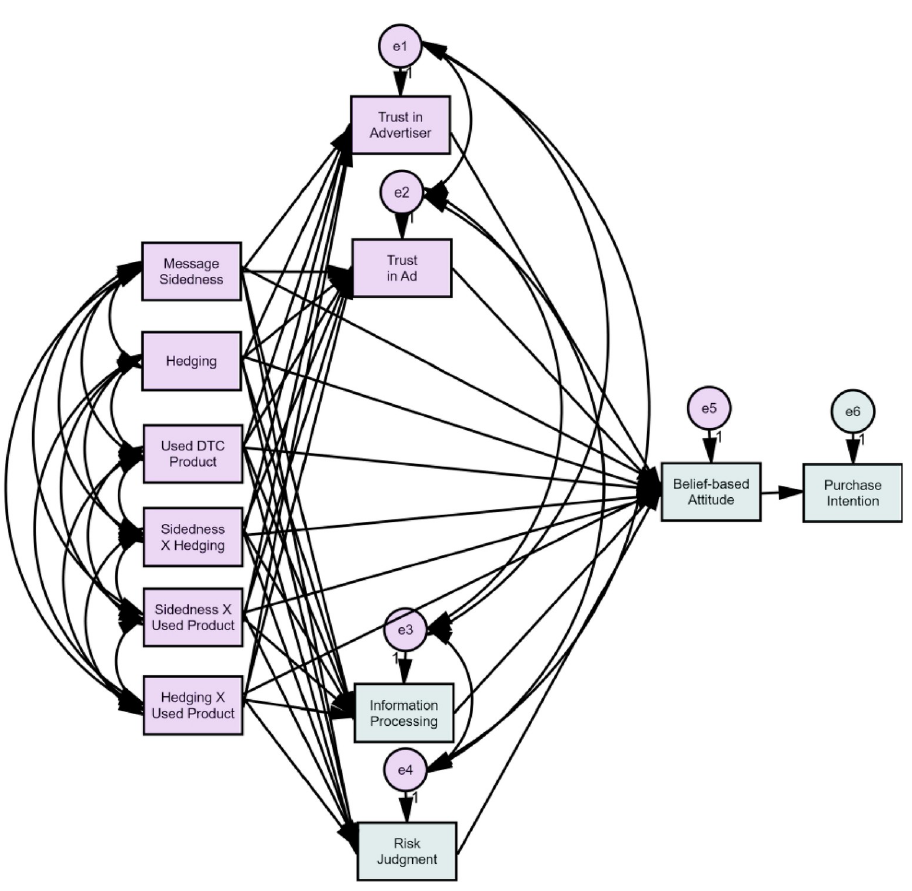
Fig 1. Hypothesized path